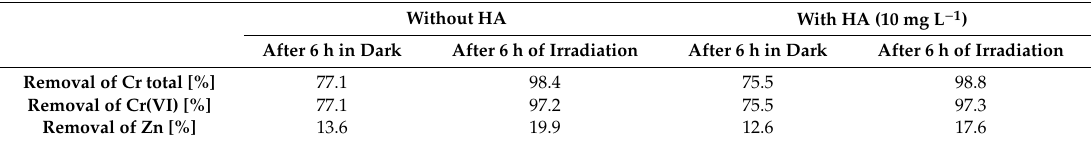
Table 1. Removals of total Cr, Cr(VI), and Zn for the diluted e ffl uent treatment with the immobilized Ce–ZrO 2 .